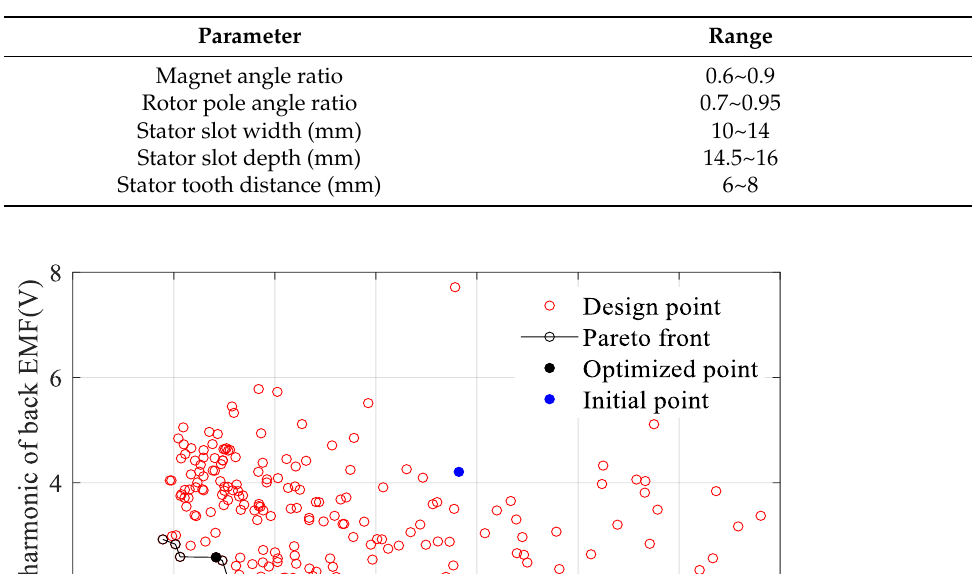
Figure 8. Flowchart of the optimization process. Table 3. Range of design parameters of the AF-FMPM machine.